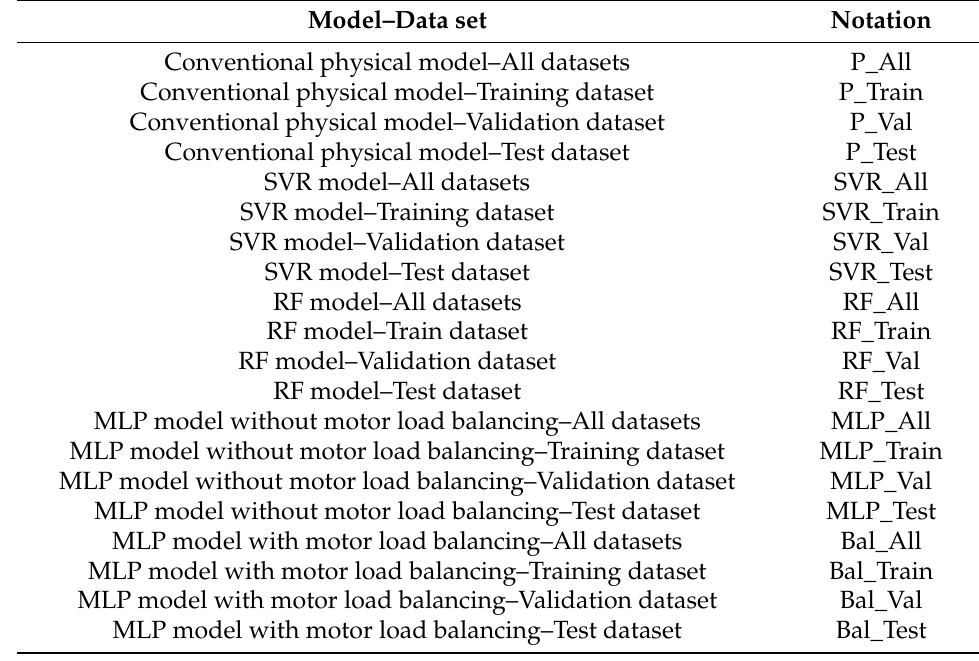
Table 11. Notations for the model–data set combinations.